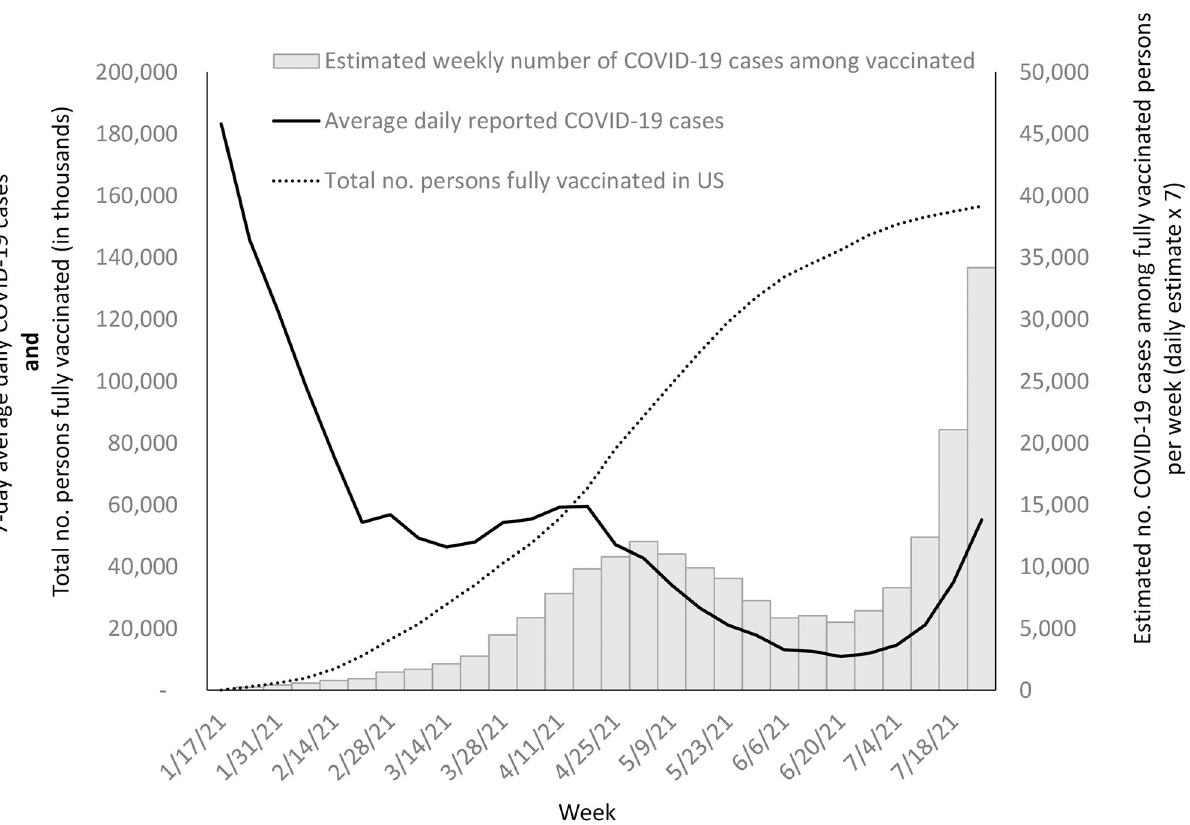
Fig 1. Estimated number of symptomatic COVID-19 cases occurring among the vaccinated population, average daily COVID-19 cases among vaccine eligible age groups, and number of persons fully vaccinated per week in the United States, January–July 2021.